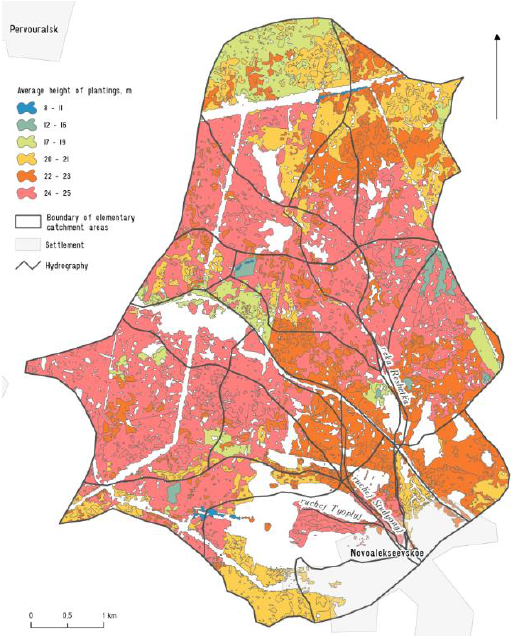
Figure 6. Average height of the trees in the forest plots of the studied region.